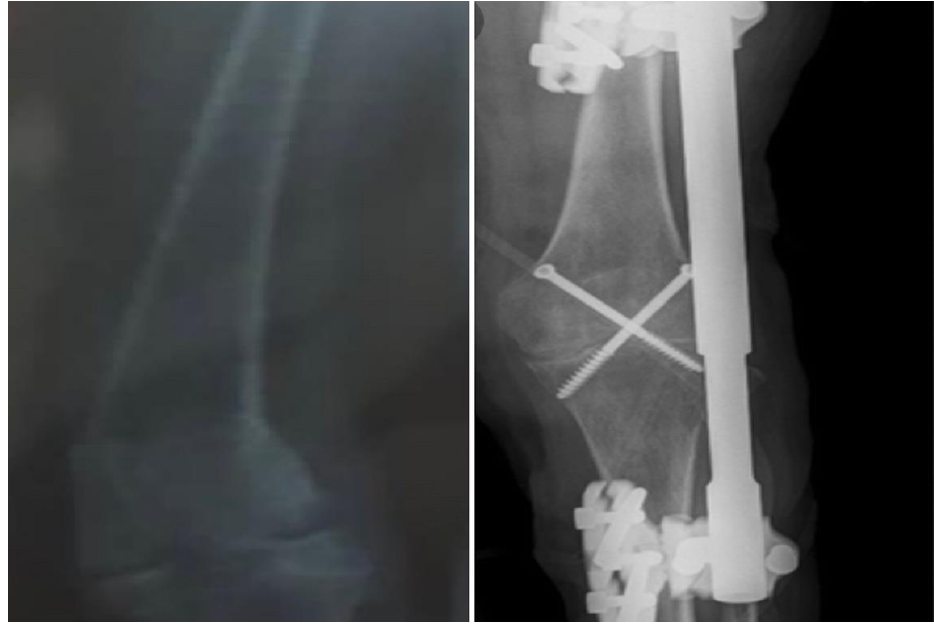
Figure 4. Plain radiograph of the left knee with lateral locking plate after the insertion of new cross- pins following a full recovery from